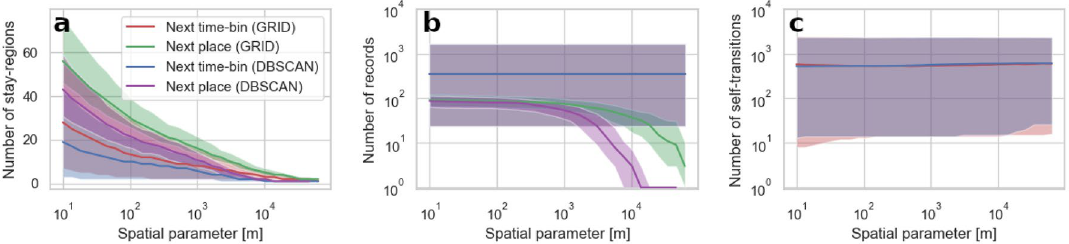
Figure 4. An impact of parameters controlling the spatial resolution of aggregated data on three types of quantitative properties of mobility sequences (number of stay-regions ( a ), number of records ( b ), and number of self-transitions ( c )). The lines represent the median value and the shaded area indicate the interquartile range of the measure calculated for all the users in the dataset. Spatial parameter relates to the variable controlling the magnitude of spatial aggregation in the grid-based approach (grid resolution) and the DBSCAN ( ǫ parameter)